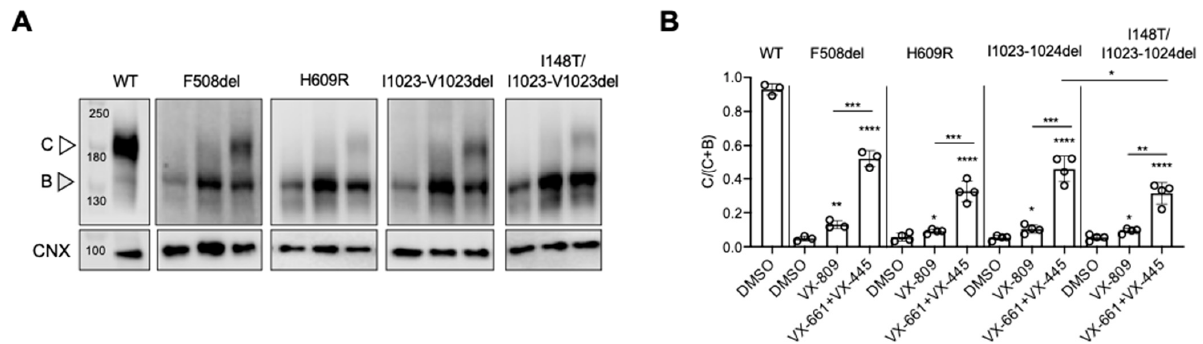
Figure 1. H609R and I1023_V1024del-CFTR exhibit protein processing defects and is restored by VX-661 + VX-445. ( A ) Immunoblots of steady-state expression of WT, F508del, H609R, I1023_V1024del, I148T/I1023_V1024-CFTR and treated for 24 h at 37 °C with: DMSO (0.1%), 3 μ M VX ‐ 809 and 3 μ M VX ‐ 661 + 3 μ M VX ‐ 445. C: mature, complex ‐ glycosylated CFTR; B: immature, core-glycosylated CFTR; CNX, Calnexin as loading control. ( B ) Bars represent the mean ( ± SD) of the ratio C/(C + B) ( n = 3–5) (* p < 0.05; ** p < 0.01; *** p < 0.001; **** p < 0.0001).